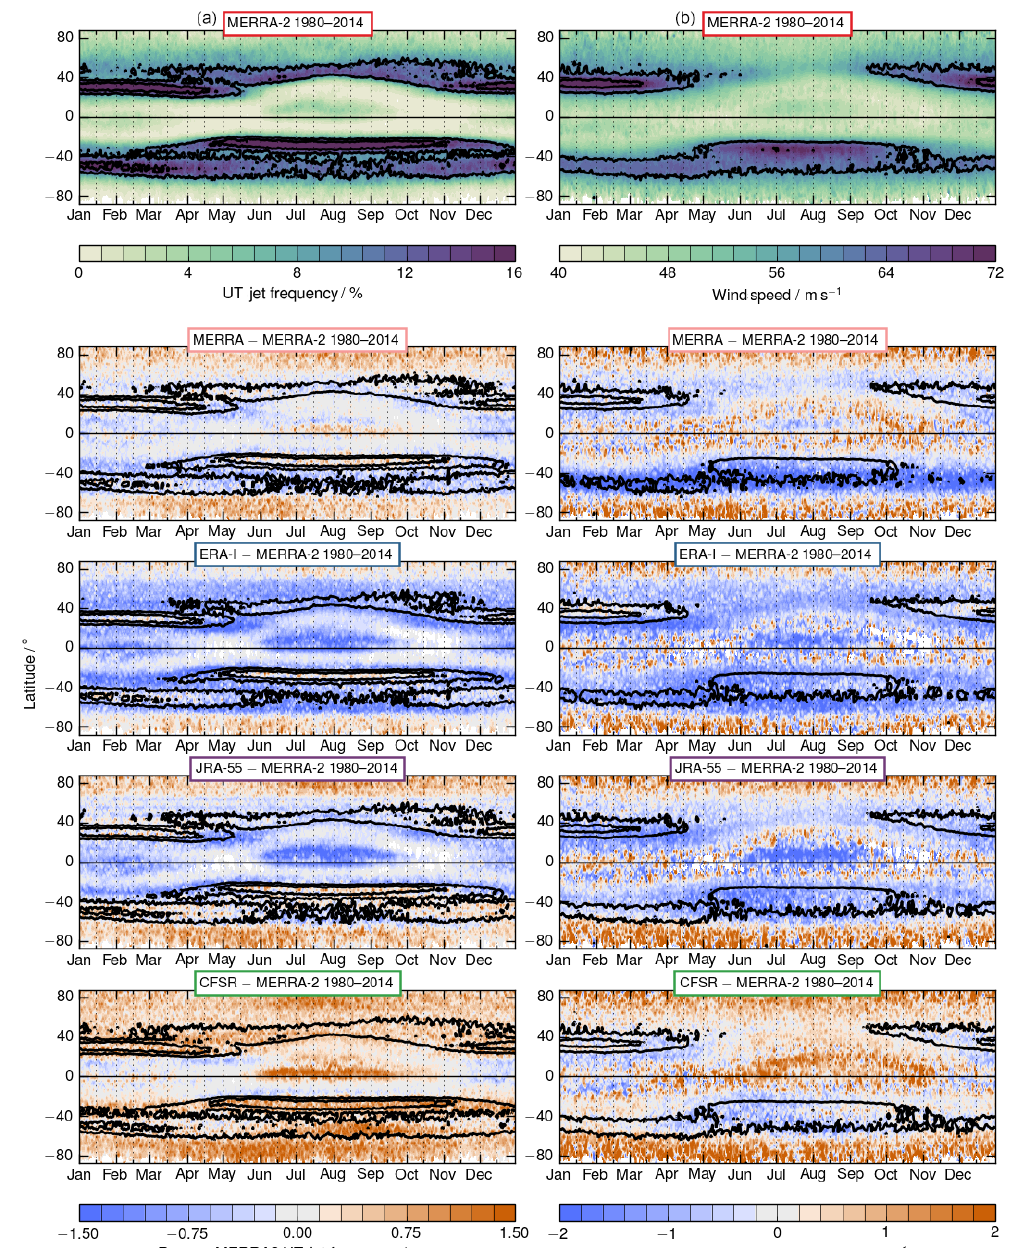
Figure 13. Climatological seasonal cycle in upper tropospheric jet frequencies for MERRA-2 compared with the other reanalyses. Jet frequency distributions are shown on the left (a) and mean wind speeds at jet cores on the right (b) . Overlaid contours are climatological values for each reanalysis of 10 and 15% for frequencies and 60 and 72ms − 1 for wind speeds; the smallest value is always the largest or “outermost” contour. In the difference plots, blues/oranges indicate negative/positive